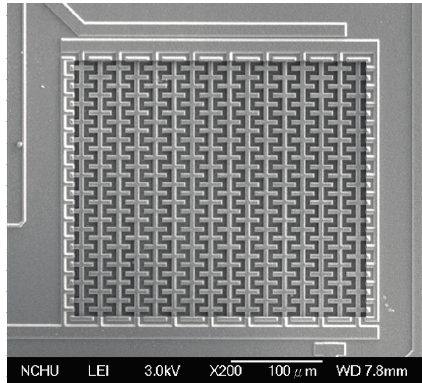
Figure 7. SEM image of the humidity sensor.